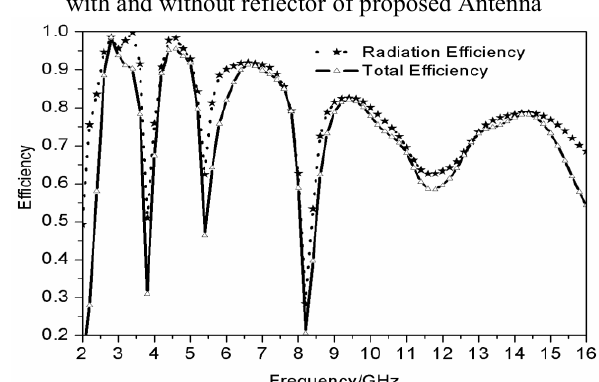
Figure 14: Variations of radiation & total efficiencies with frequency of proposed antenna with reflector